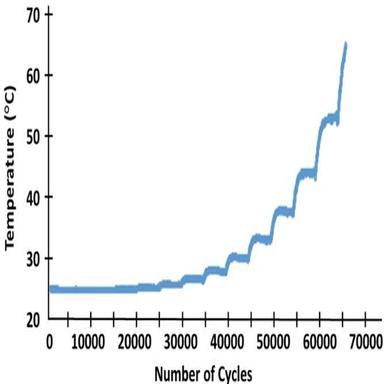
Typical TSA raw temperature rise for Type A material during stepwise increases in stress every 5000 cycles for compression-compression tests. Similar data were obtained for Type B material.